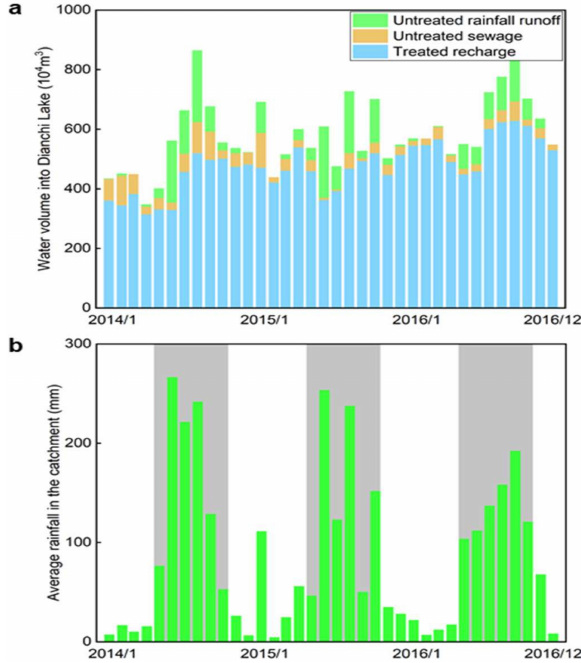
Figure 9. ( a ) Monthly discharged water volume delineated by each nutrient source; ( b ) monthly average rainfall depth measured by seven rain gauges in the catchment. Shaded areas indicate rainy season periods (May − October).